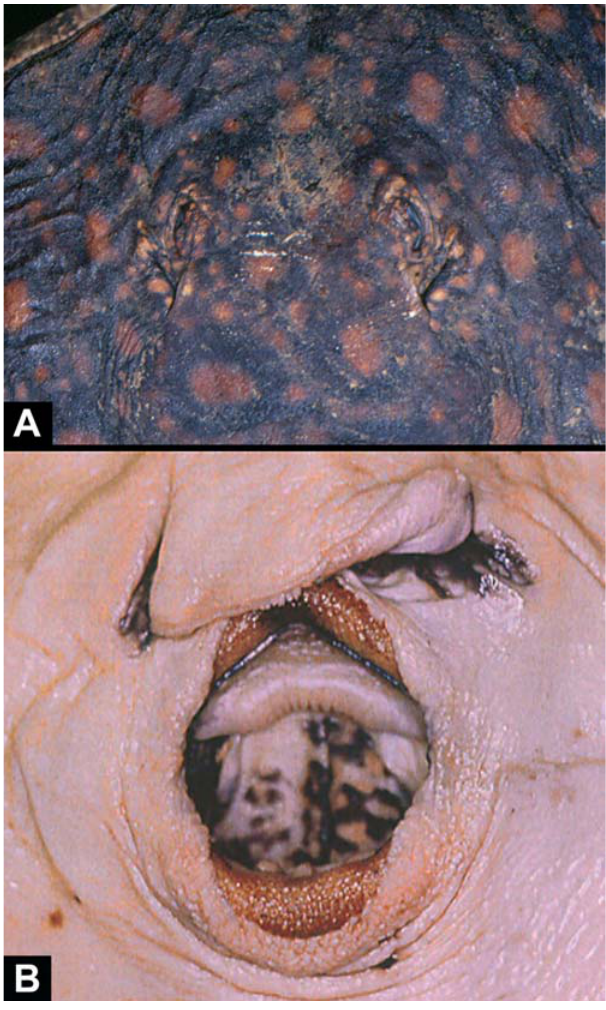
Fig. 2. Potamotrygon boesemani . Detailed view of interor- bital region ( A ) and of mouth and nasal cavity ( B ) of holo- type (USNM 225574, 377 mm DW).